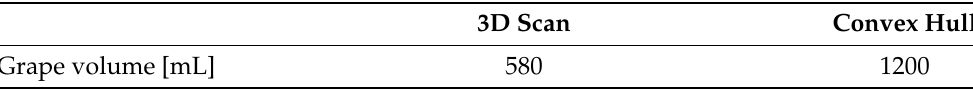
Table 2. Grape volume measured using